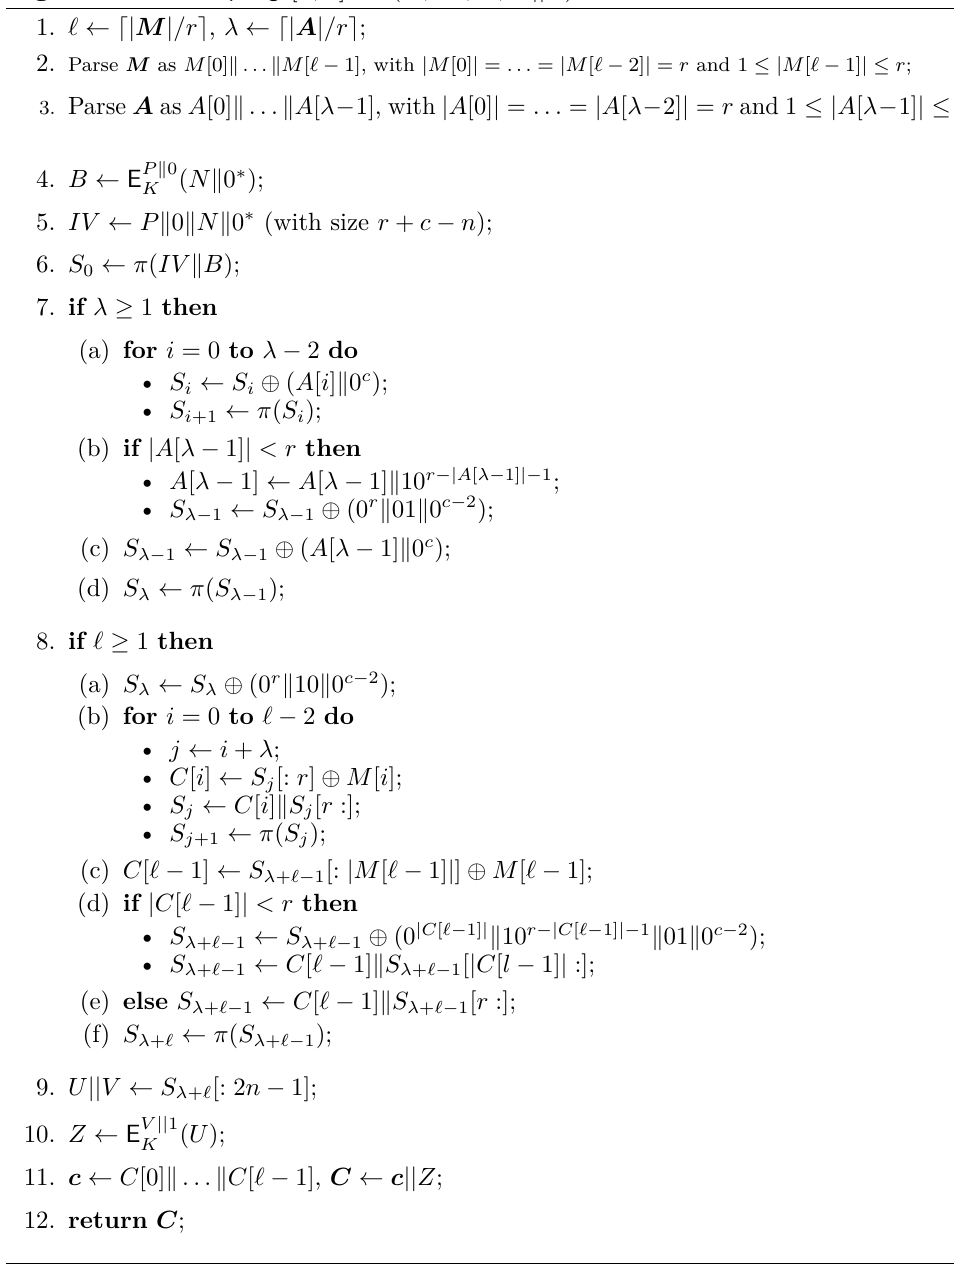
Algorithm 3 TETSponge [ E , π ] . Enc ( A , M , N, K || P